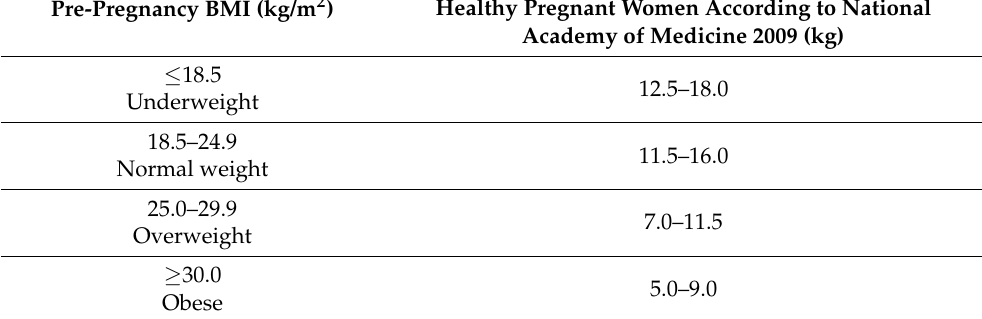
Pre-Pregnancy BMI (kg/m 2